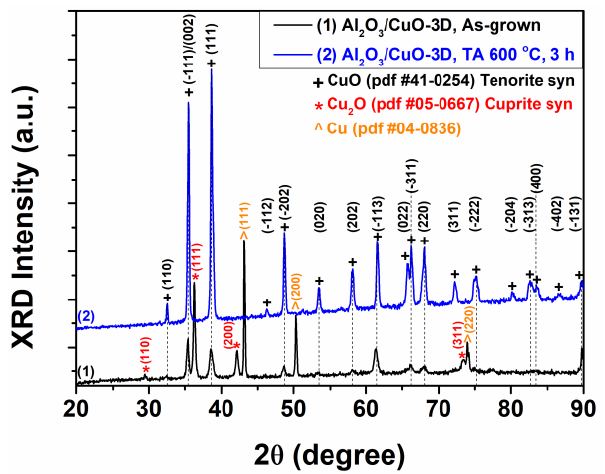
Figure 3. SEM images of the Al 2 O 3 /CuO-3D heterostructures after annealing at different scales: ( a ) 100 µm; ( b ) 10 µm; ( c ) 2 µm; and ( d ) 400 nm.